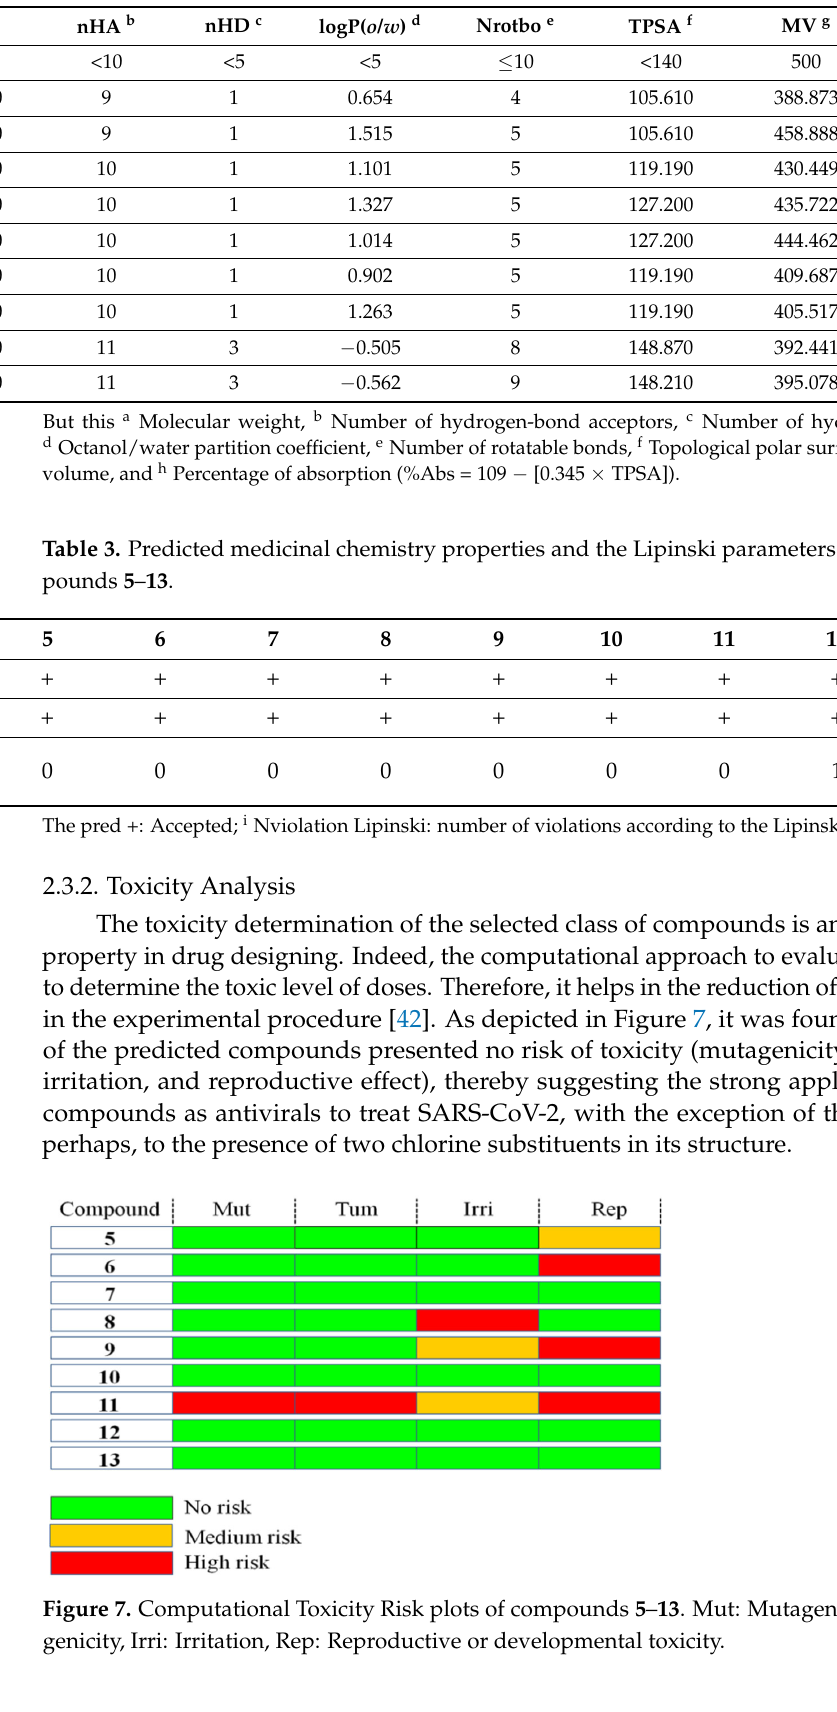
Table 2. Predicted physicochemical properties for the target compounds 5 – 13 .